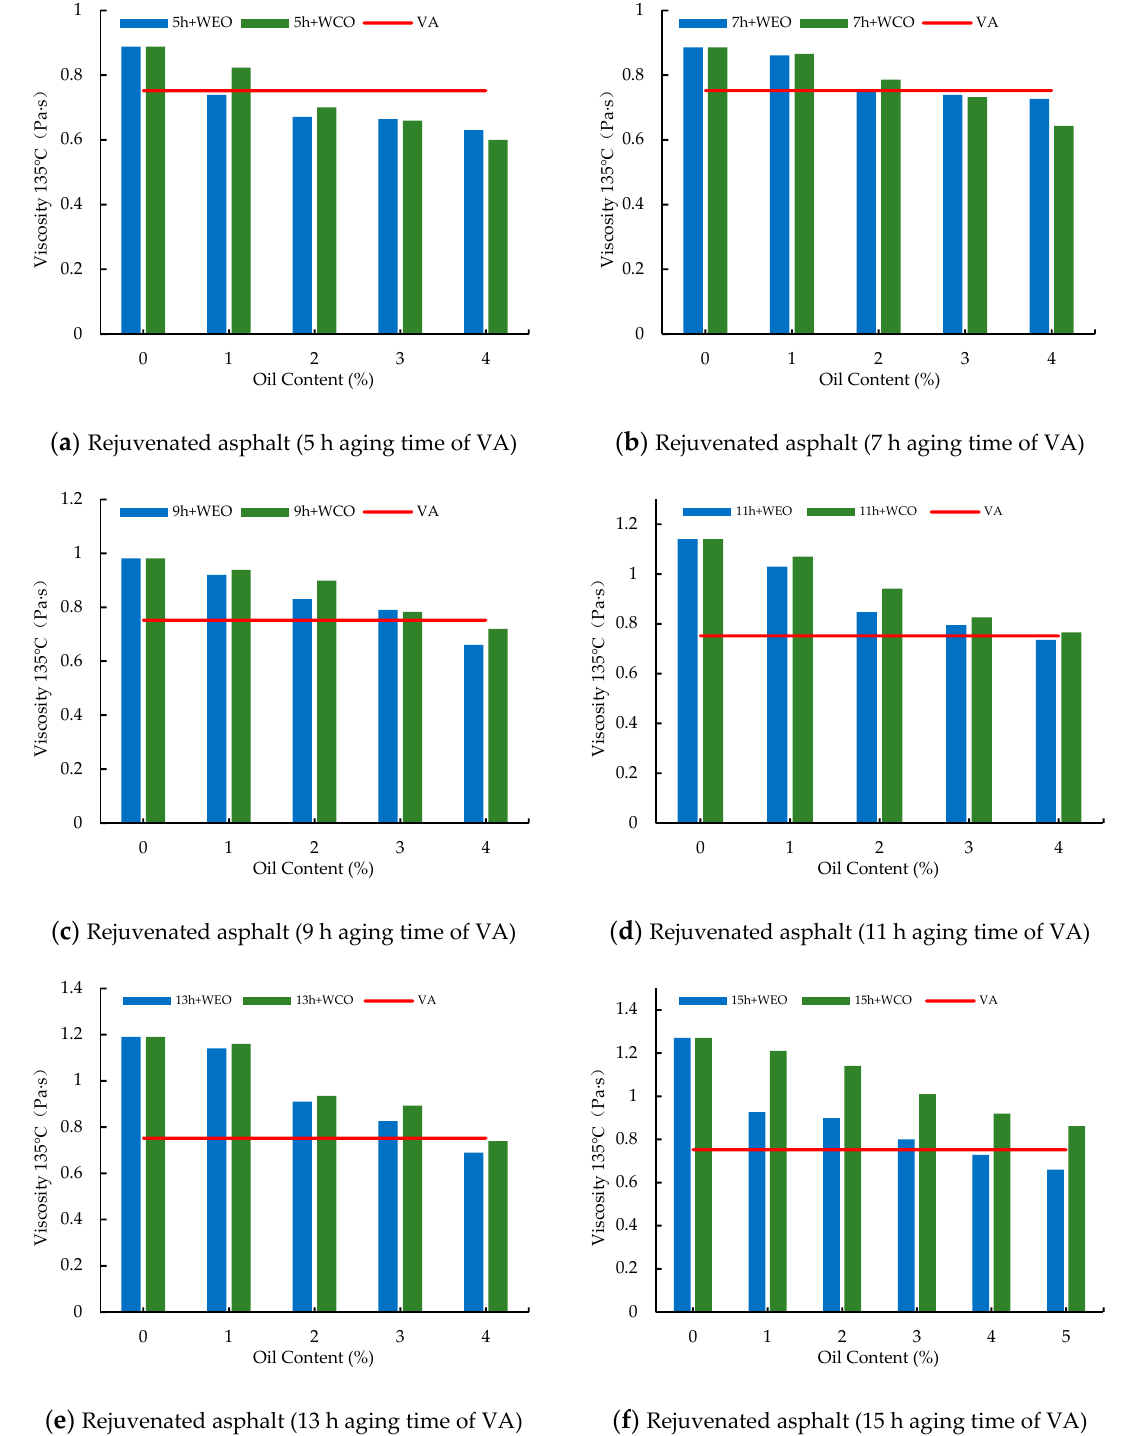
Figure 9. Effects of WEO and WCO on viscosity of different aged asphalt. Figure 9. E ff ects of WEO and WCO on viscosity of di ff erent aged